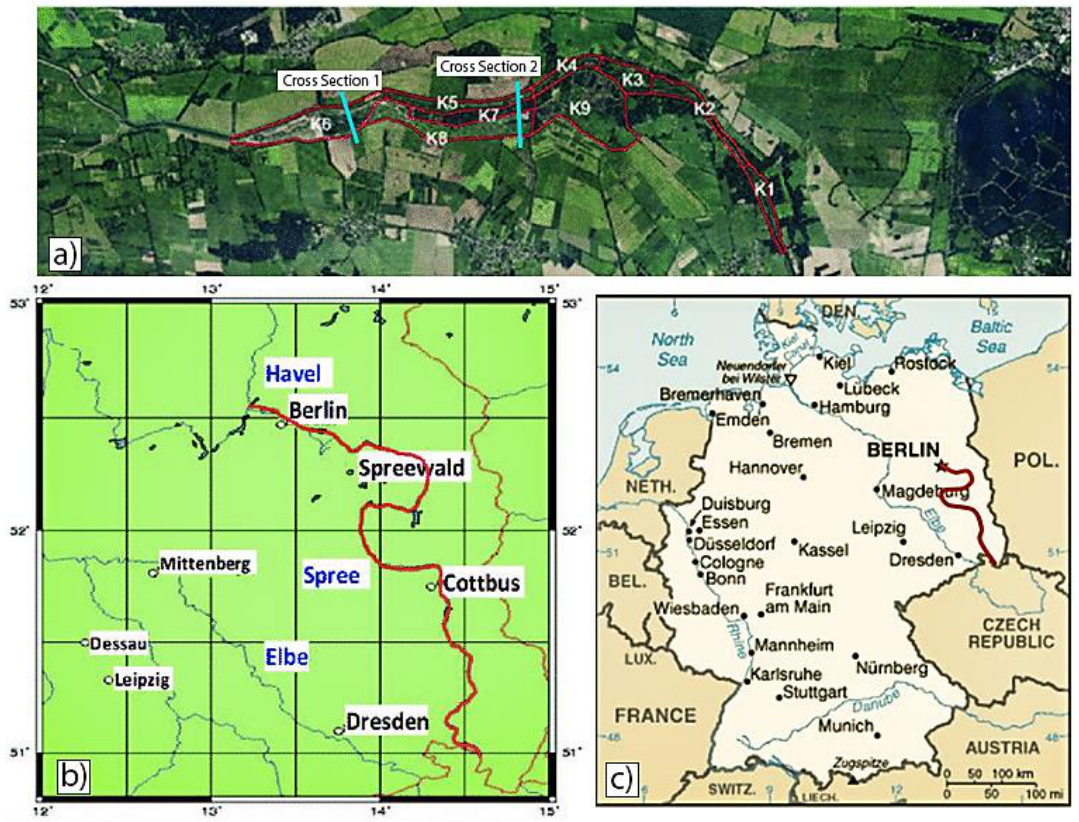
Figure 1. ( a ) Satellite image of the study area, ( b ) Channel across the major geographic locations, and (c) river location in Germany are illustrated in the figure.